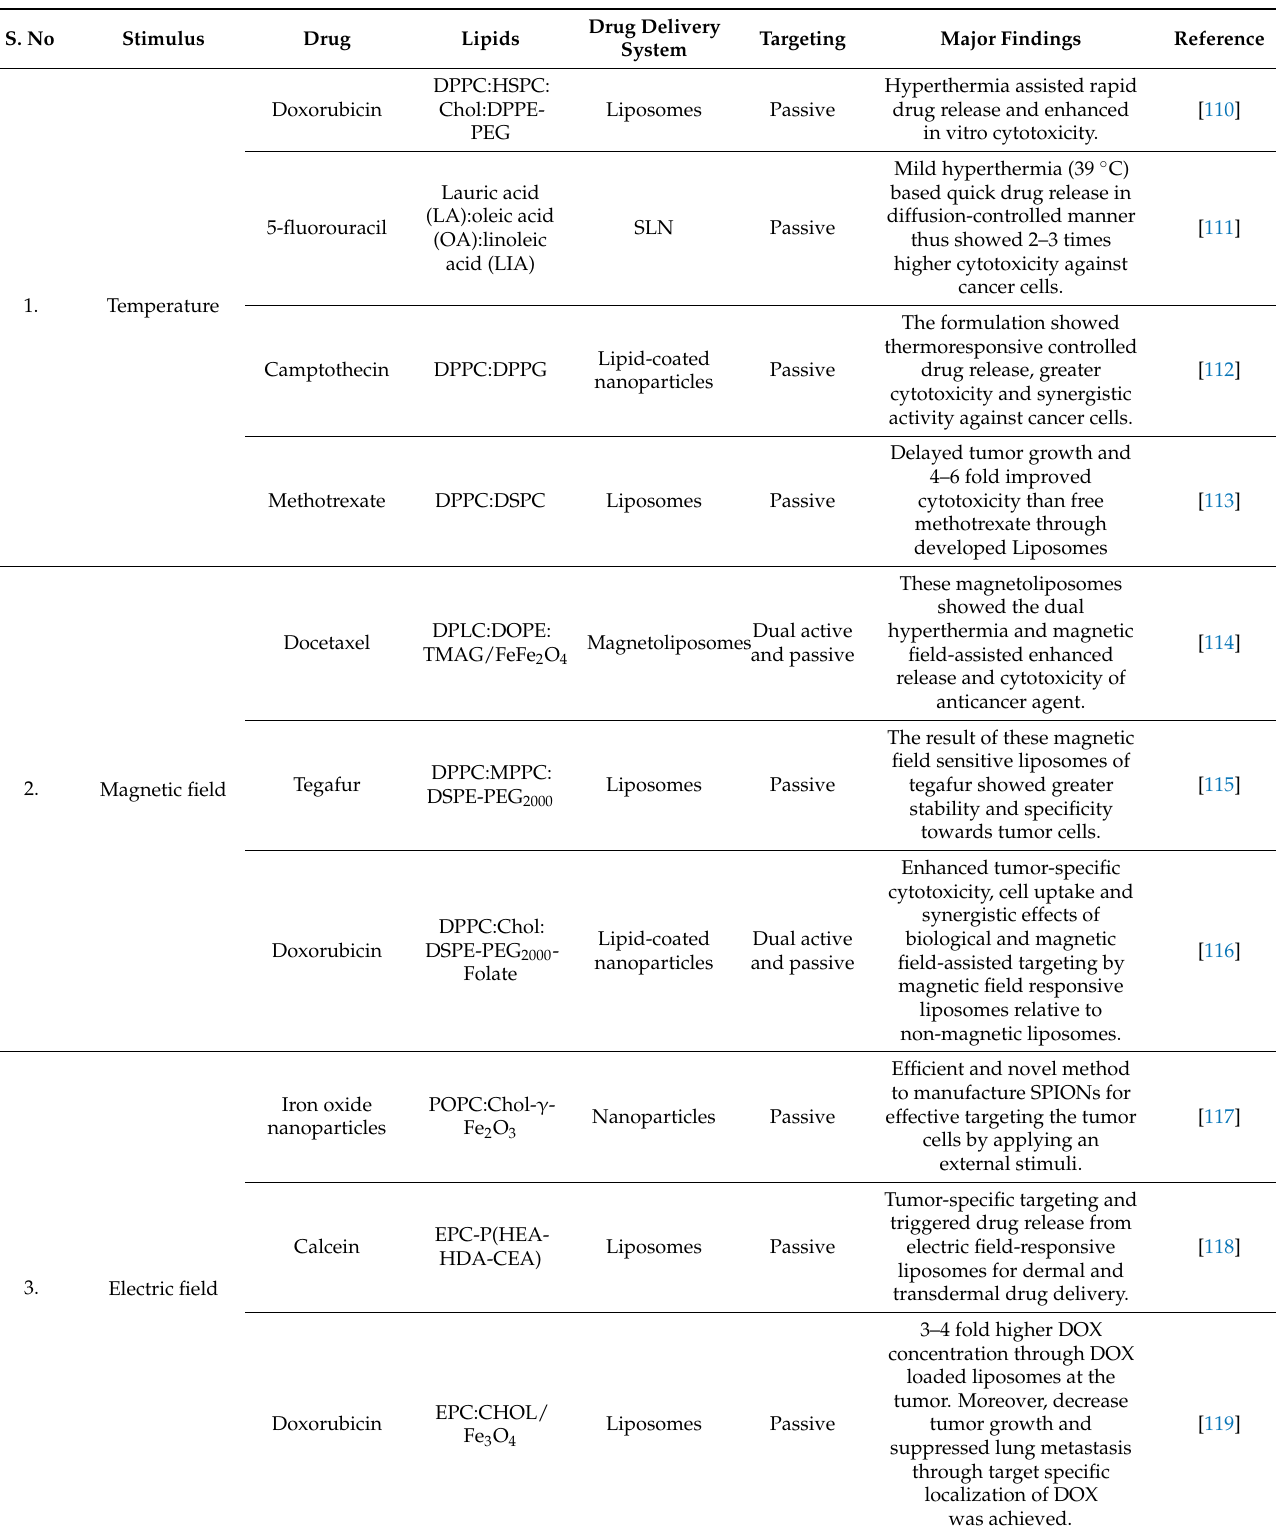
Table 2. Stimuli-Responsive Lipid-Based Drug Delivery Systems for Cancer